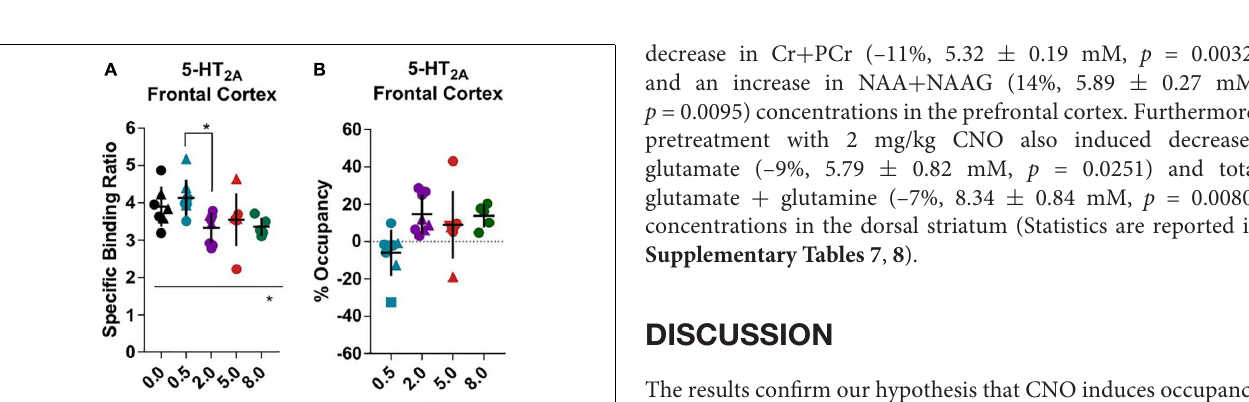
no effect of pretreatment with 0.5 mg/kg CNO in comparison to vehicle in either the prefrontal cortex or dorsal